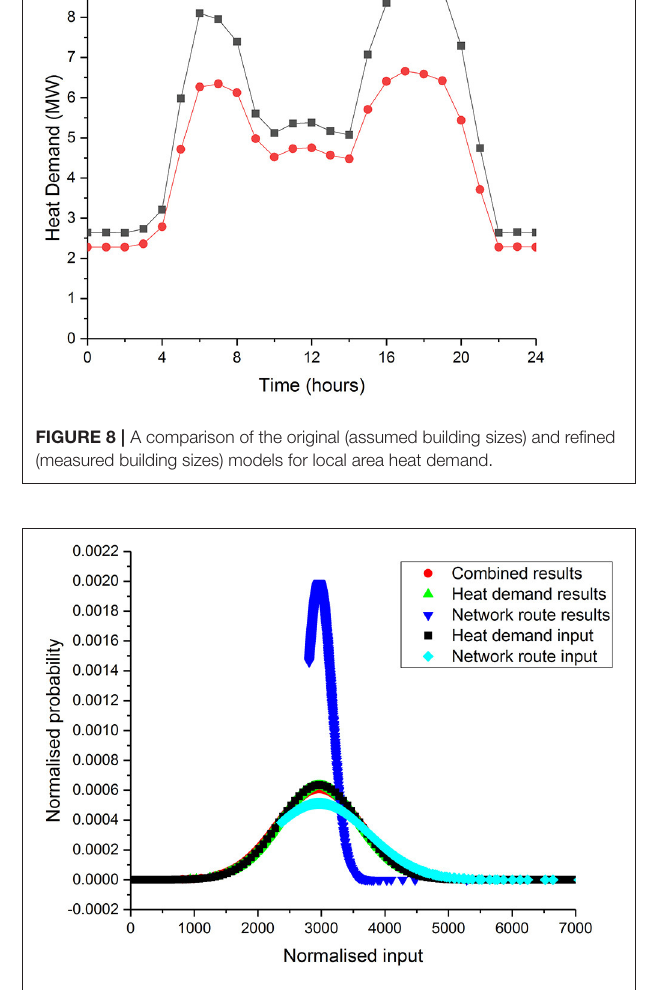
FIGURE 9 | The distribution of the heat demand from the global (including the error from the measurement process) and individual Monte Carlo simulations as well as the distributions of heat demand and network route length as found in the